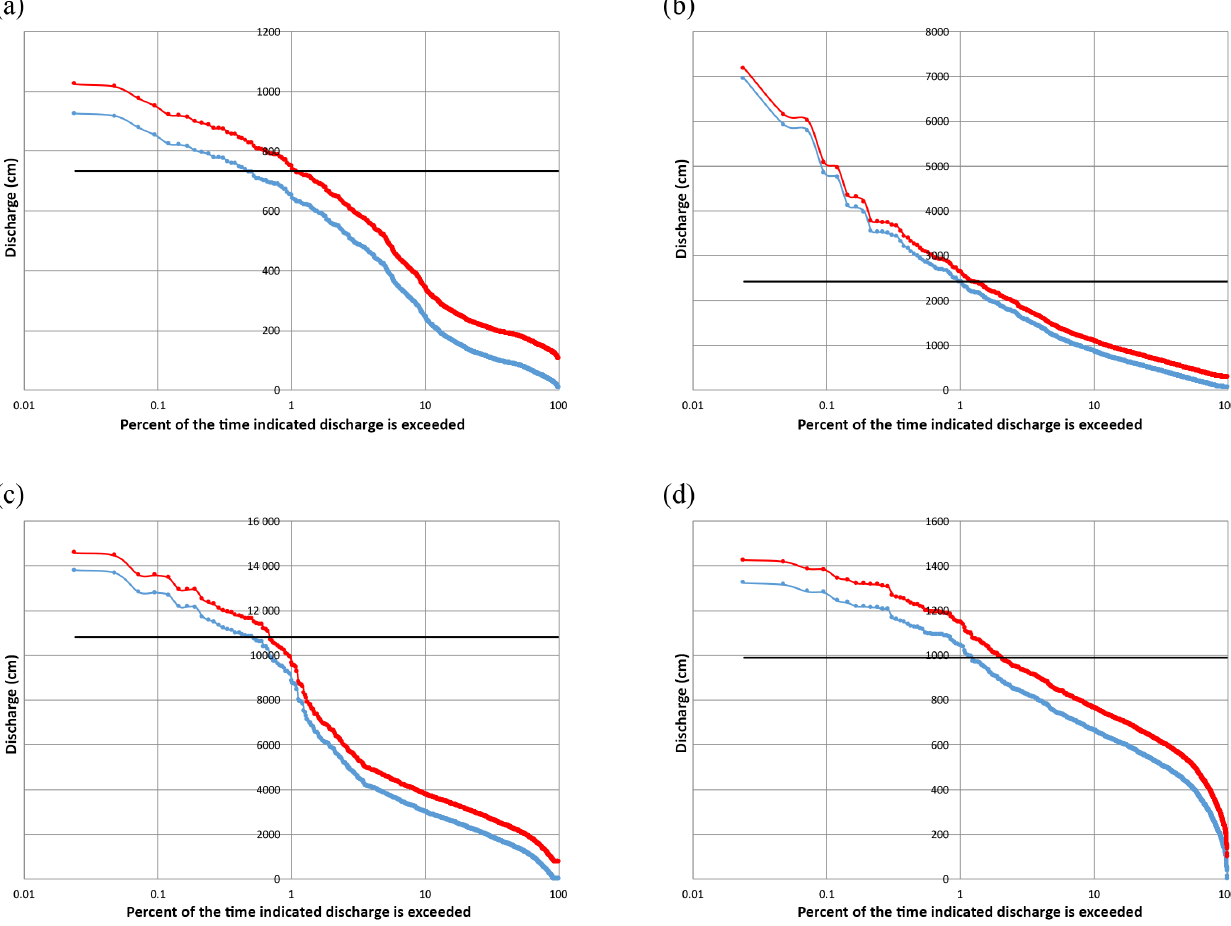
Figure 5. Bankfull discharge (black lines), flow duration curves (blue curves), and flow duration curves with discharge increased due to the average tropical cyclone (red curves) for an extended May–December hurricane season on the Neches (a) , Pearl (b) , Mobile (c) , and Roanoke (d) rivers.